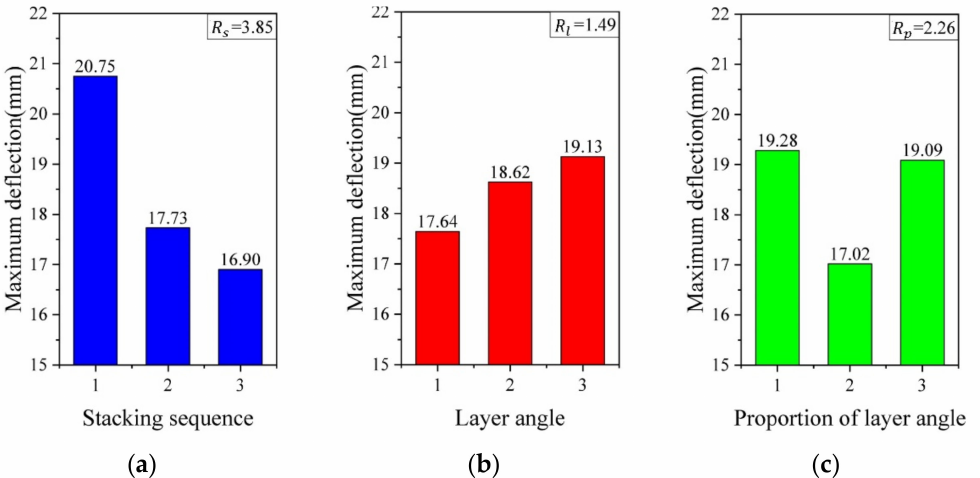
Figure 13. The average value of per level for the ( a ) stacking sequence, ( b ) layer angle and ( c ) proportion of the layer